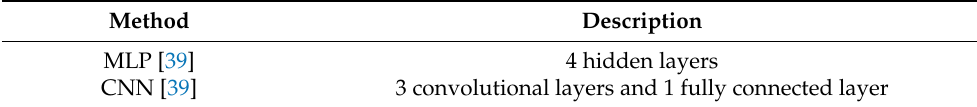
Table 4. Compared RUL prediction methods for the N-CMAPSS